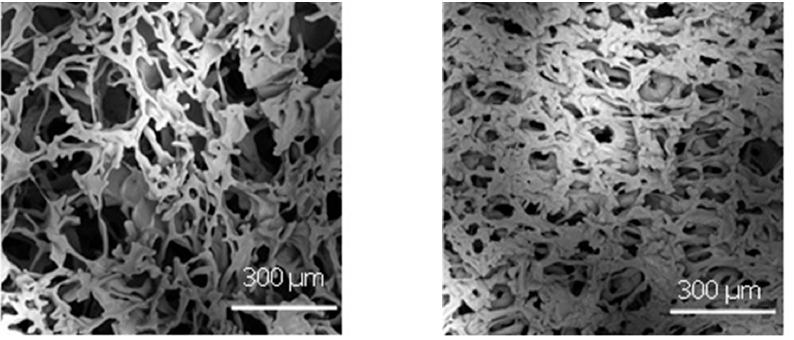
Figure 8. SEM micrographs at the dried cake centre in the case of ( left ) vials nested in a rack system and ( right ) in direct contact with the shelf. Freezing was conducted using a cooling rate of 0.5 °C min − 1 .